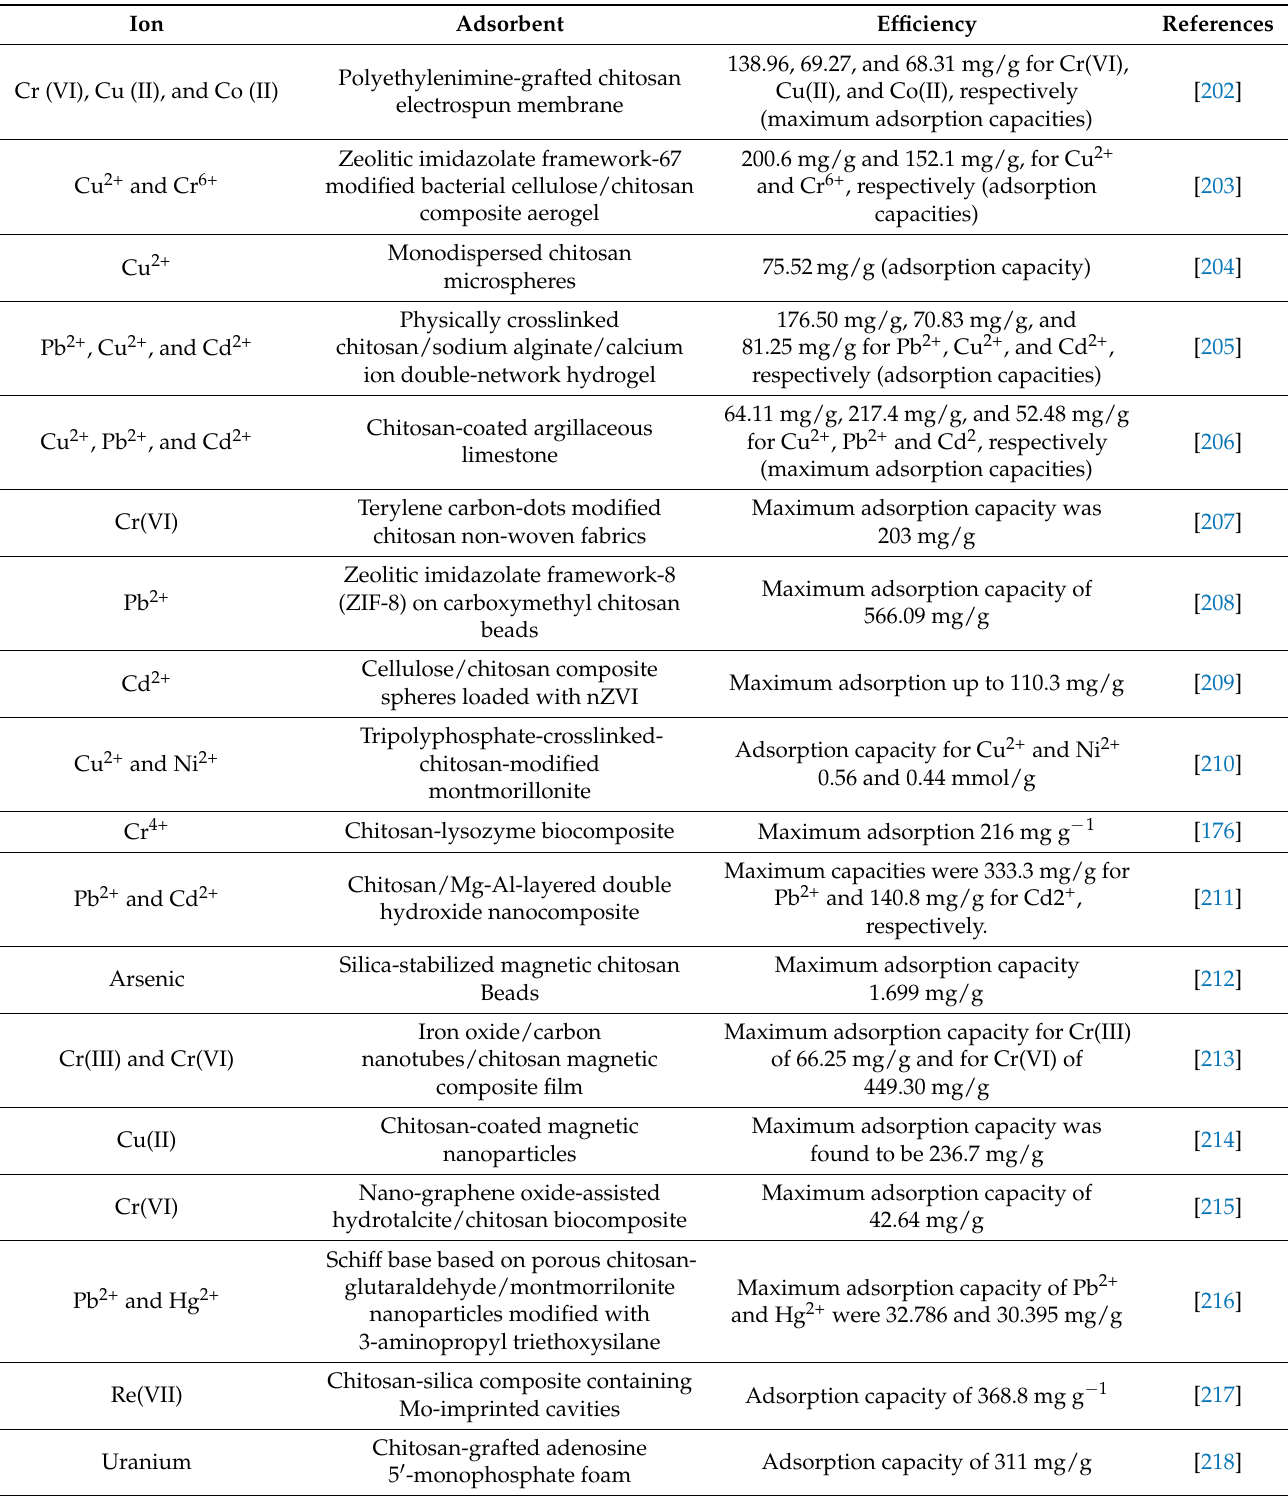
Table 8. Examples of chitosan for removing